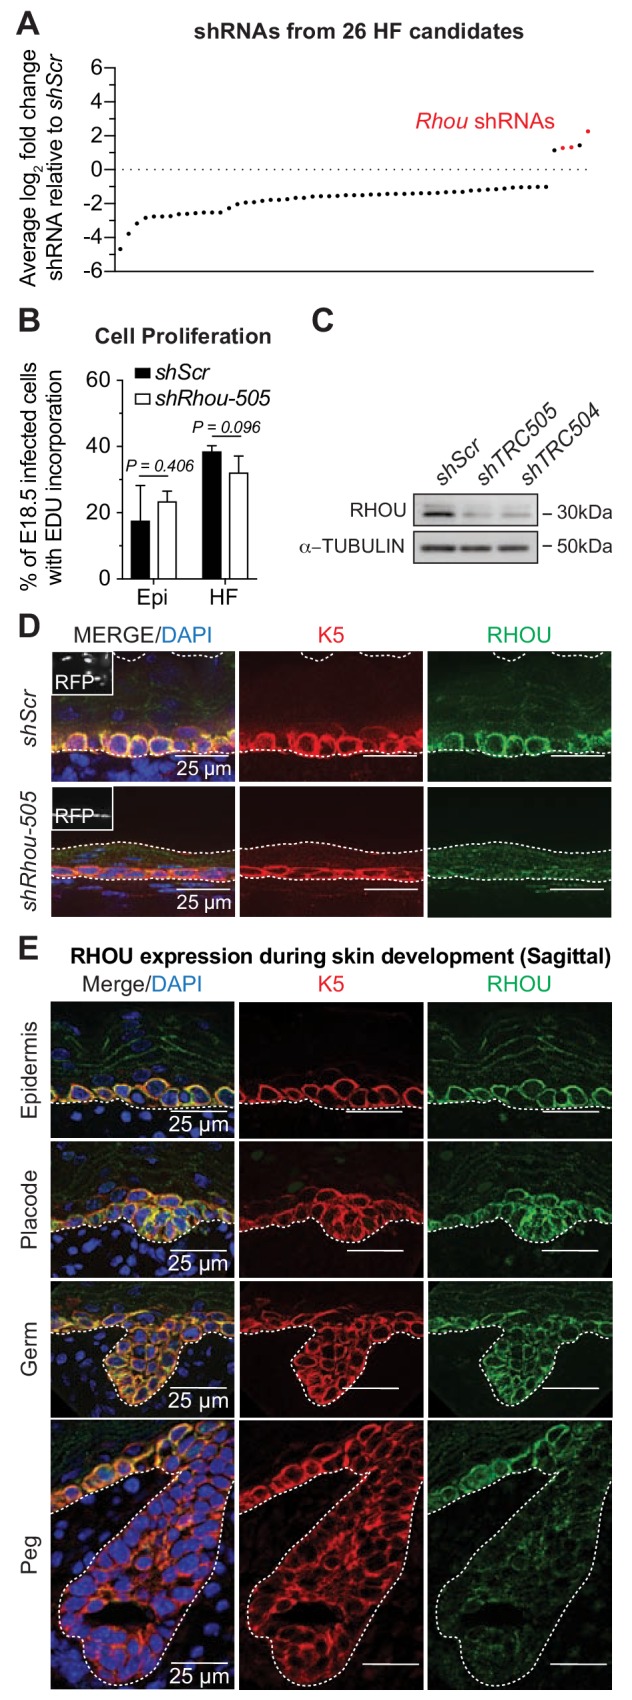
RHOU, an unusual positive hit from our RNAi screen for Rho GTPase regulators of morphogenesis.(A) In vivo screen results show the absolute log2 fold changes of shRNAs targeting the 26 candidates specifically enriched or depleted in the HF fraction. shRNAs targeting Rhou are highlighted in red. (B) Epidermal and HF cell proliferation is not affected by RHOU loss. Quantifications of epidermal and HF EDU incorporation to quantify the numbers of S-phase cells. Error bars represent SEM from n = 3 shScr and n = 3 shRhou-505 embryos. Normal distribution of the data was testes using the Shapiro-Wilk test. Parametric independent unpaired two-tailed t-test was used to compare the data. (C–D) RHOU immunoblot (C) and immunofluorescence (D) of E16.5 skin substantiate antibody efficacy and effective RHOU depletion by shRNA-mediated knockdown in vitro and in vivo. Scale bars, 25 μm. (E) RHOU immunofluorescence reveals expression in basal epidermal progenitors, but downregulation as HF morphogenesis proceeds. Representation of n = 3 embryos. Scale bars, 25 μm.10.7554/eLife.50226.010Figure 3—source data 1.Source data related to Figure 3B.